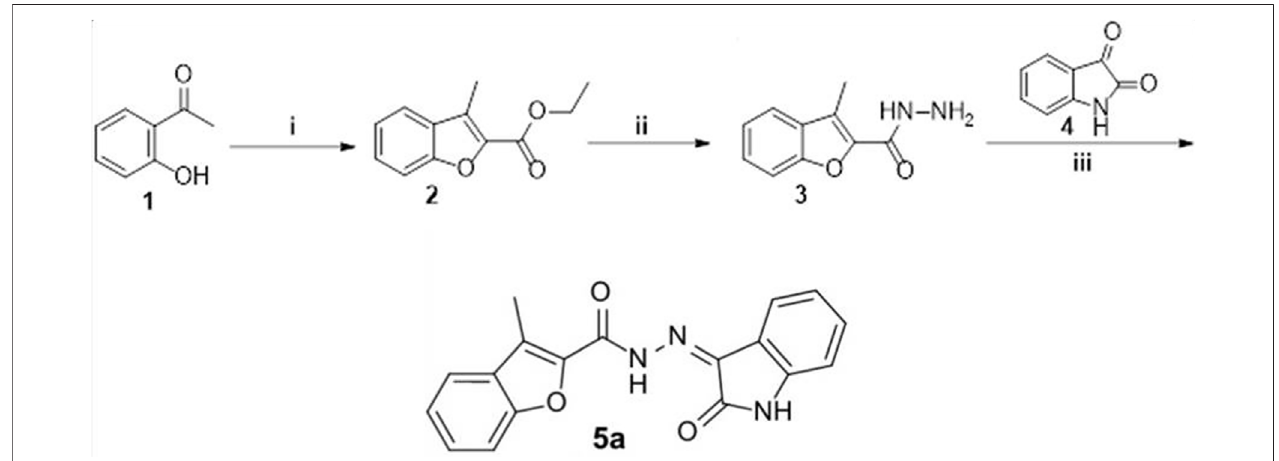
FIGURE 1 | Synthesis of Compound 5a. (i) Ethyl 2-bromoacetate, anhydrous acetonitrile, K2CO3, re fl ux 8 h; (ii) hydrazine hydrate, methyl alcohol, re fl ux 4 h; (iii) ethanol/AcOH (Cat.)/re fl ux 5